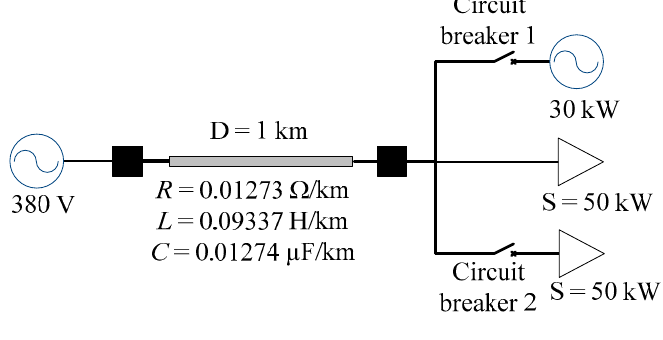
Figure 9. Disturbance simulation model. Table 2. Disturbance simulation settings.